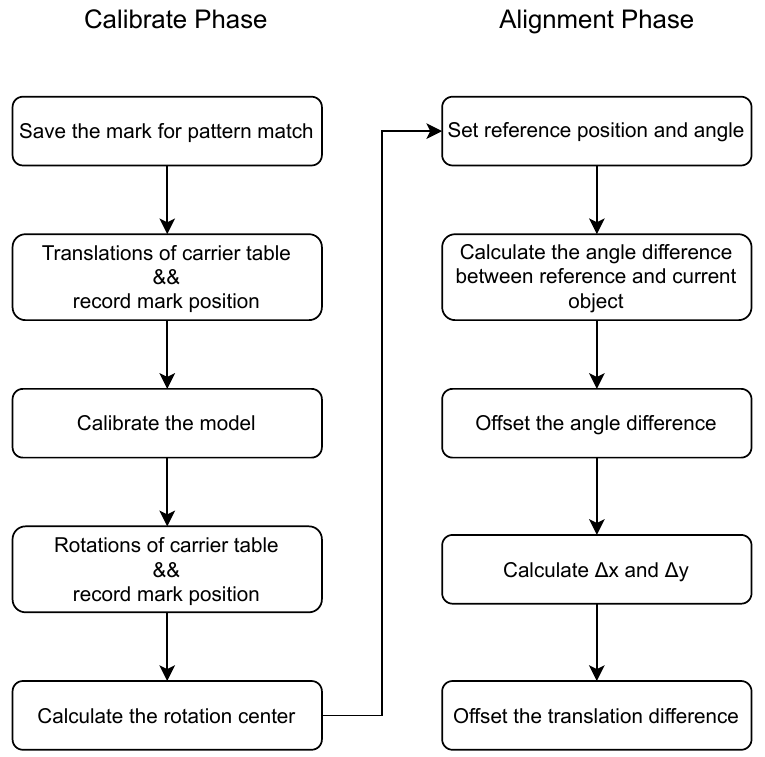
Figure 6. This flowchart indicates the steps to simultaneously calibrate the camera and calculate the center of rotation of the